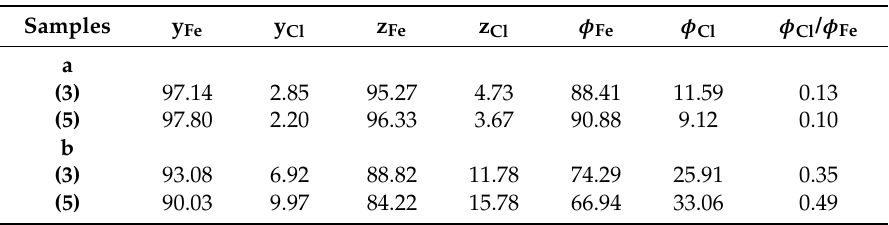
Table 4. Molar fraction percentages (y i ), mass fraction percentages (z i ), and volume fraction percentages ( φ i ) determined by (a) EDS and (b)